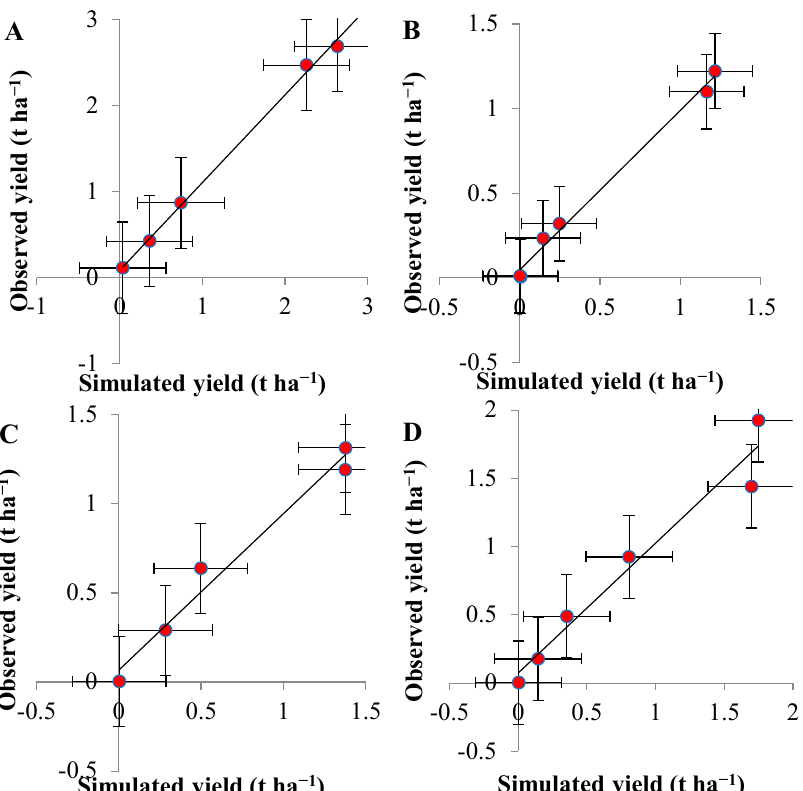
Figure 5. Evaluation of simulated yield for oilseed flax for the studies conducted in Dingxi ( A ); Zhangjiakou ( B ); Wulanchabu ( C ); and Datong ( D ). Note: the horizontal and vertical error bars denote S.E. for the simulated and observed.